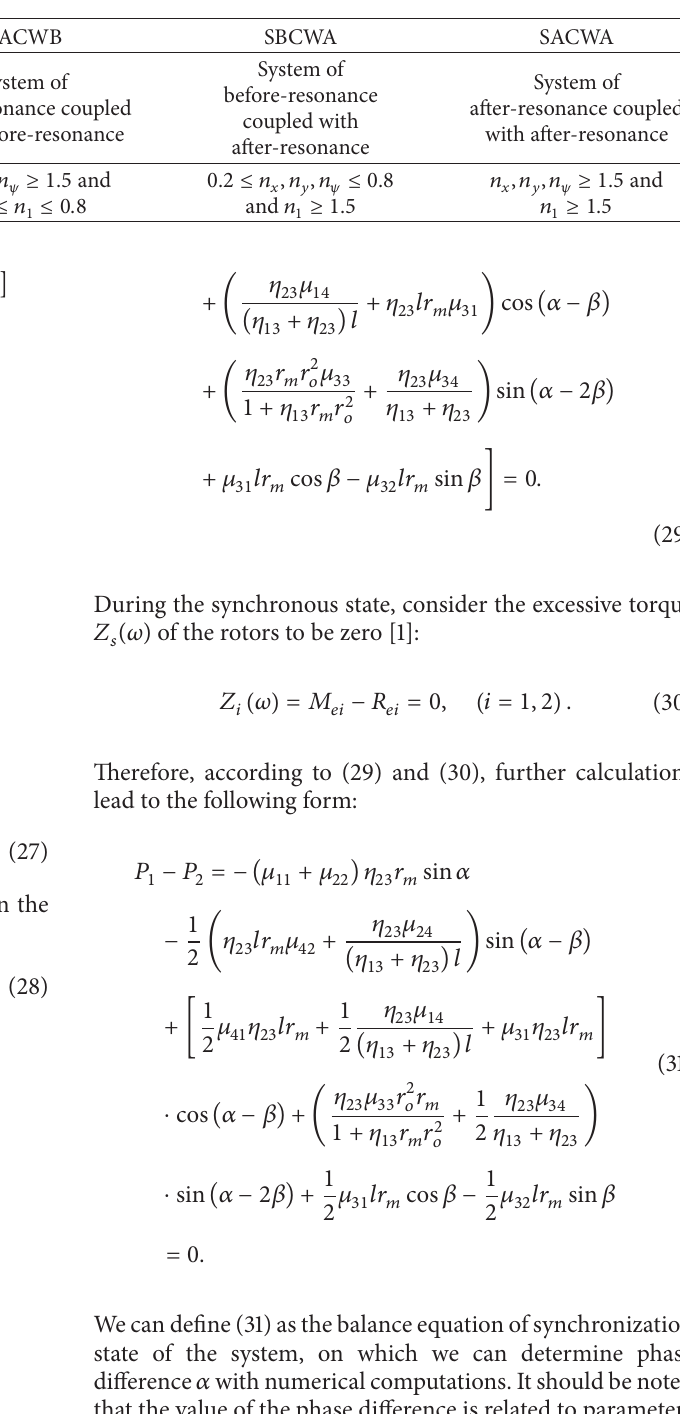
Table 2: Type of the coupling